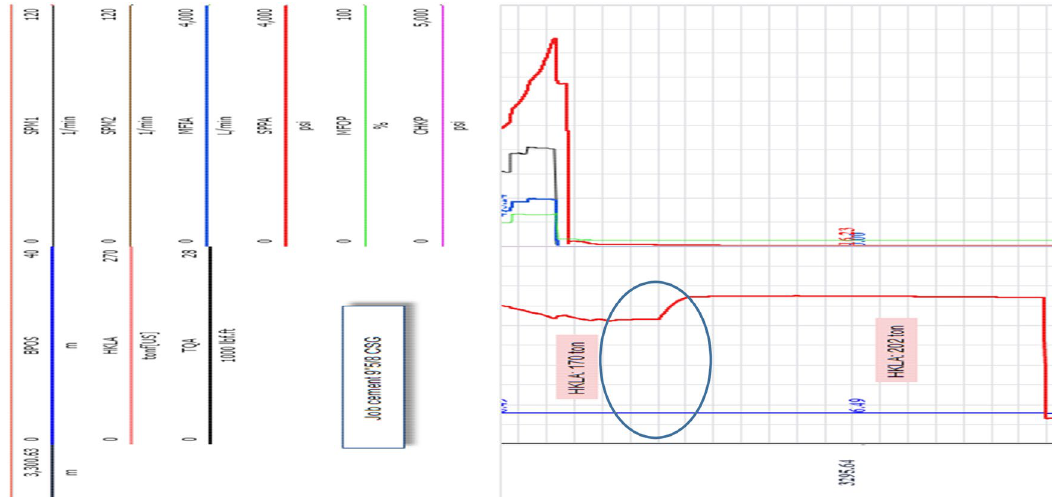
Fig. 12 9 5/8 casing cement end of job chart, pressure bleed off Table 5 Casing buckling